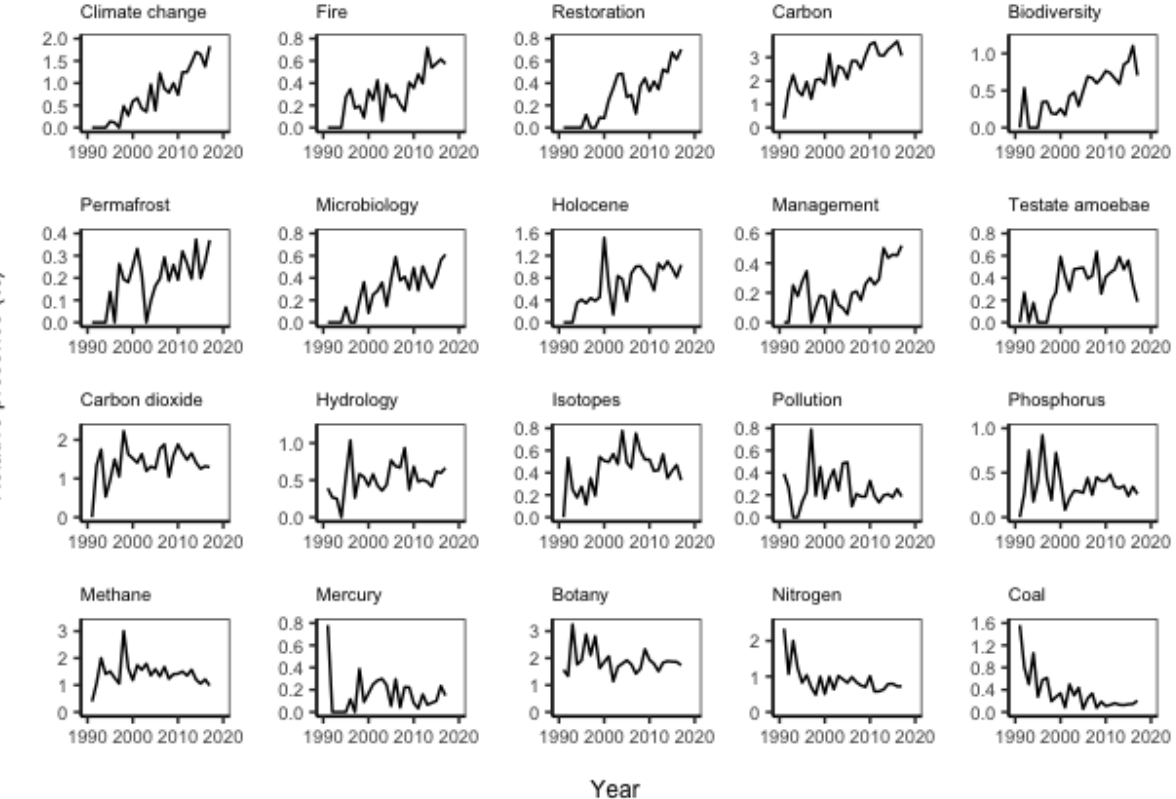
Figure 11. Research activity indicators per topic, defined by the quotient of the number of occurrences of each keyword in a given year and the total number of keywords for the same year. Topics are ordered from left to right according to the intensity of change over the entire interval, quantified by the difference of the average z-scores of the 1991–1995 and the 2011–2017 periods. Z-scores were defined by subtracting the mean from each value and subsequent division by the standard deviation of the